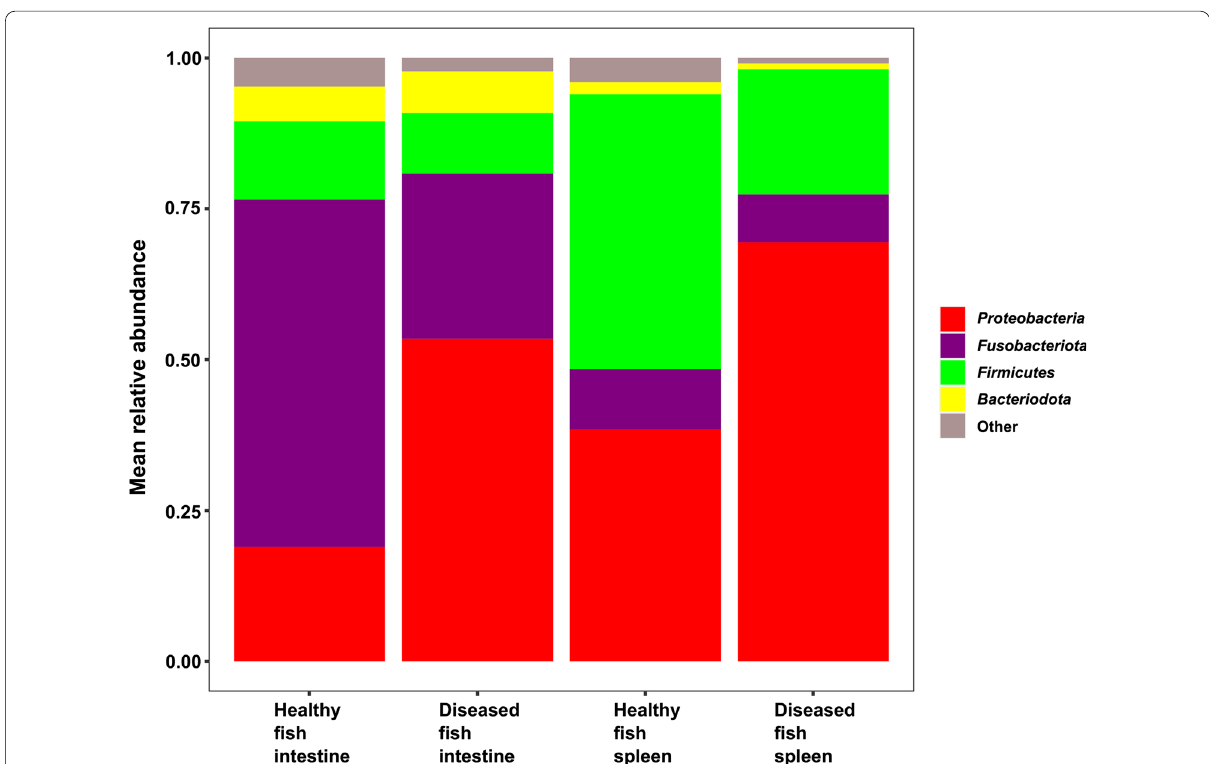
Fig. 3 Phylum level mean relative abundance in the intestine and spleen microbiota of healthy and diseased fish